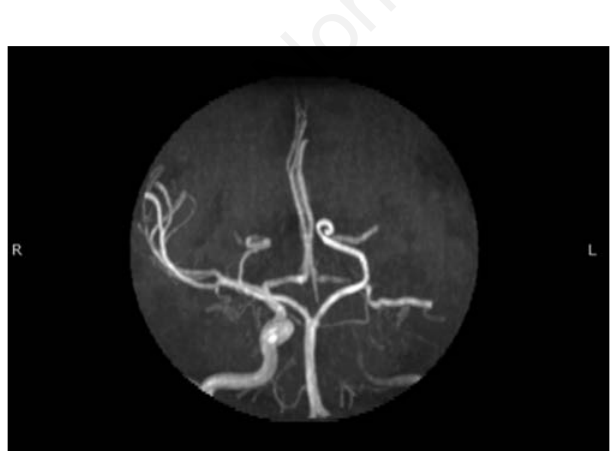
Figure 2. FLAIR magnetic resonance imaging showing a gliotic and poroencephalic outcome of the previous ischemic lesion in left cortical-subcortical fronto-temporal region, with ex-vacuo dilatation of ipsilateral